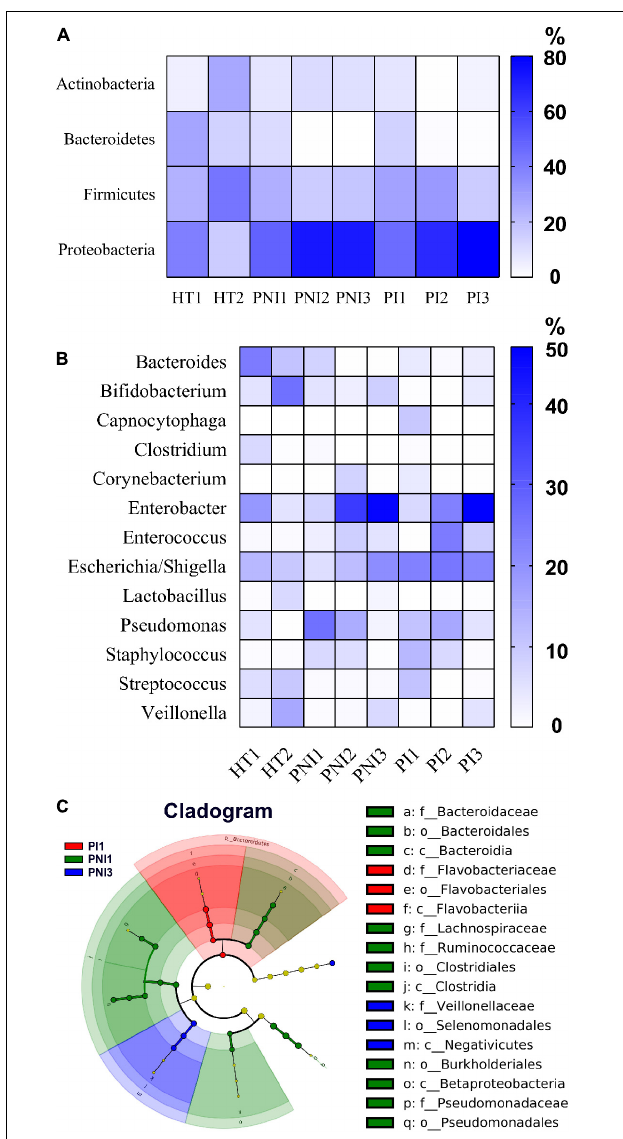
FIGURE 3 | The main compositional proportion of gut microbiota and LefSe analysis. Phylum (A) and genus (B) levels for each group of participants expressed in heatmaps are shown. (C) The cladogram diagram shows the microbial species with significant differences in the three groups. Inside to outside showed the species classification at the level of phylum, class, order, family, and genus. The red, green, and blue nodes in the phylogenetic tree represent microbial species that play an important role in the PI1, PNI1, and PNI3 groups, respectively. Yellow nodes represent species with no significant difference.